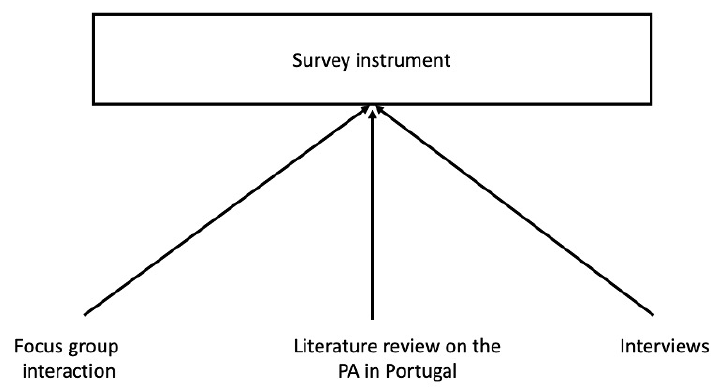
Figure 3. The development of the survey instrument. Source: Own elaboration.